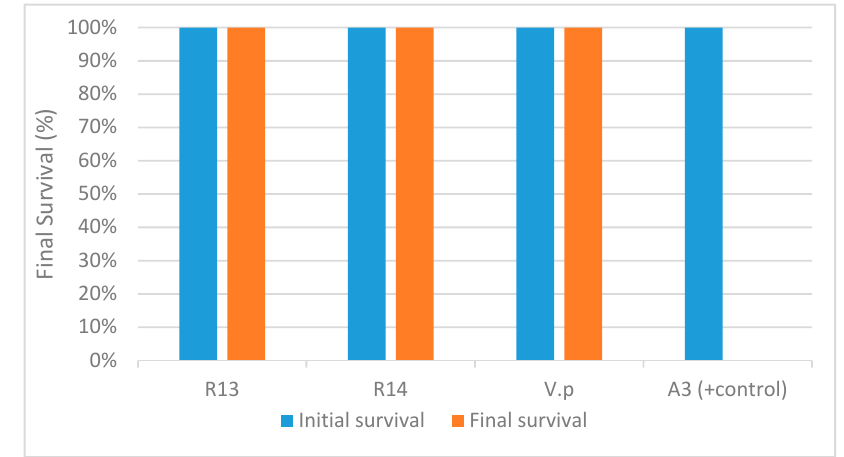
Figure 2. Final survival rate of shrimp, Penaeus vannamei , experimentally infected with four different isolates of Vibrio parahaemolyticus —R13, R14, A3 (reference AHPND strain) and VP ATCC strains. Data set represents the mean of two replicates for each strain.